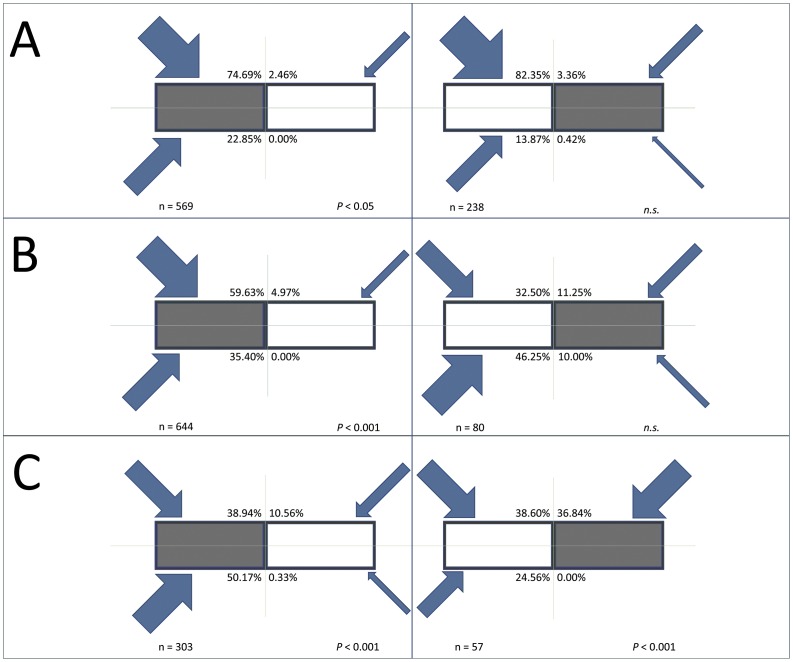
Schematic bird’s eye view of watering troughs manipulated for the experiment at sites A, B and C.For each site one watering trough was covered with Perspex (grey rectangle), the other was left uncovered (white) so that water was available to bats. Two replicates of the experiment were done at each site, covering a different watering trough each time (left and right respectively). The arrows indicate the general direction (±45°) from which the bats approached the watering trough for drinking. Arrow width is proportional to the numbers of bats approaching from each direction (percent values are also given). Most bats always came from one side (and, in four out of six cases, one quadrant – see P values of Fisher’s exact tests in figure) and drank at the first watering trough encountered, so that the latter was disproportionately used over the other regardless of whether it had been covered with Perspex or not.